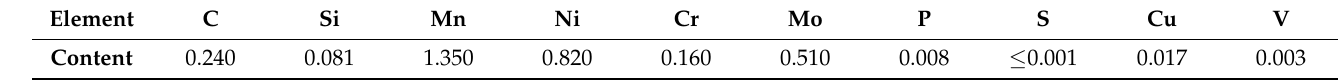
Table 4. SA508-III steel composition. (wt%, mass fraction).